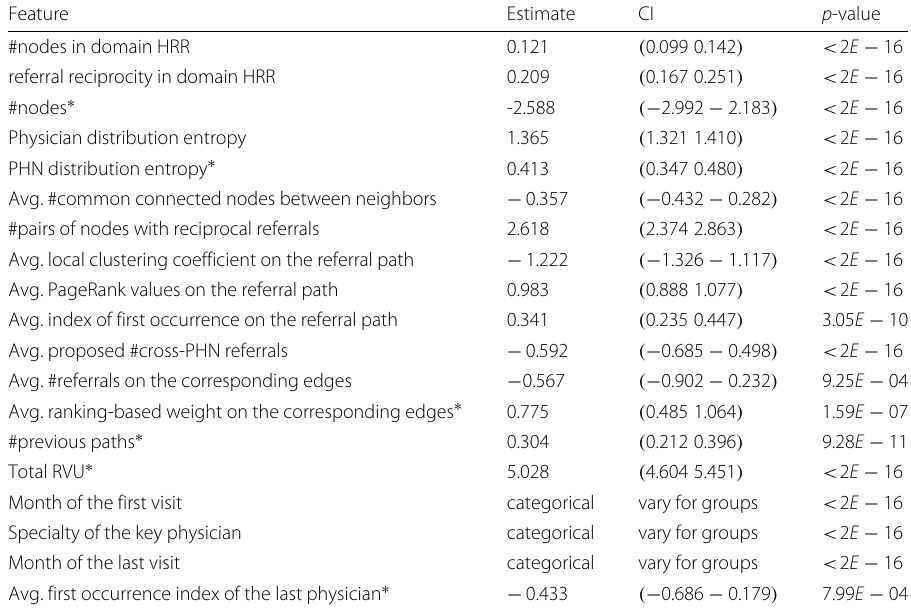
Table 16 Significant predictors in multiple linear regression models for log(Total 1yr payments) with estimated coefficients in %95 confidence interval (CI)